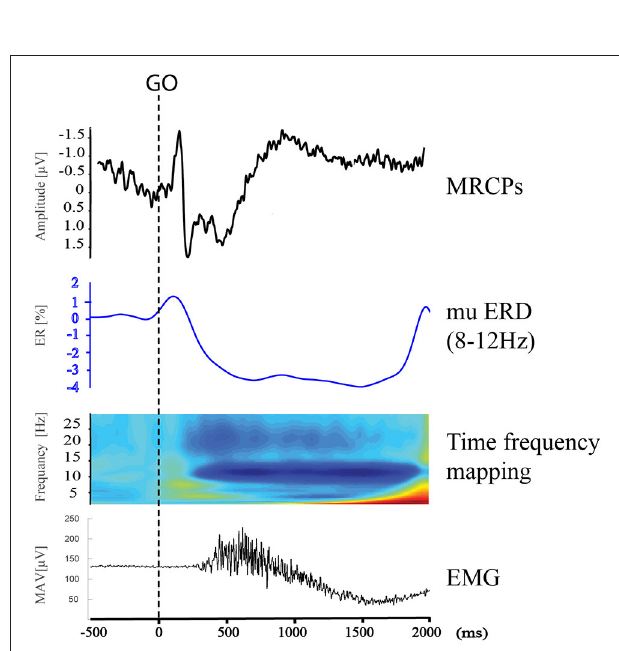
FIGURE 7 | MRCPs, mu ERD, time frequency mapping at C3, and right upper limb EMG during Right Wrist Extension in IRM.